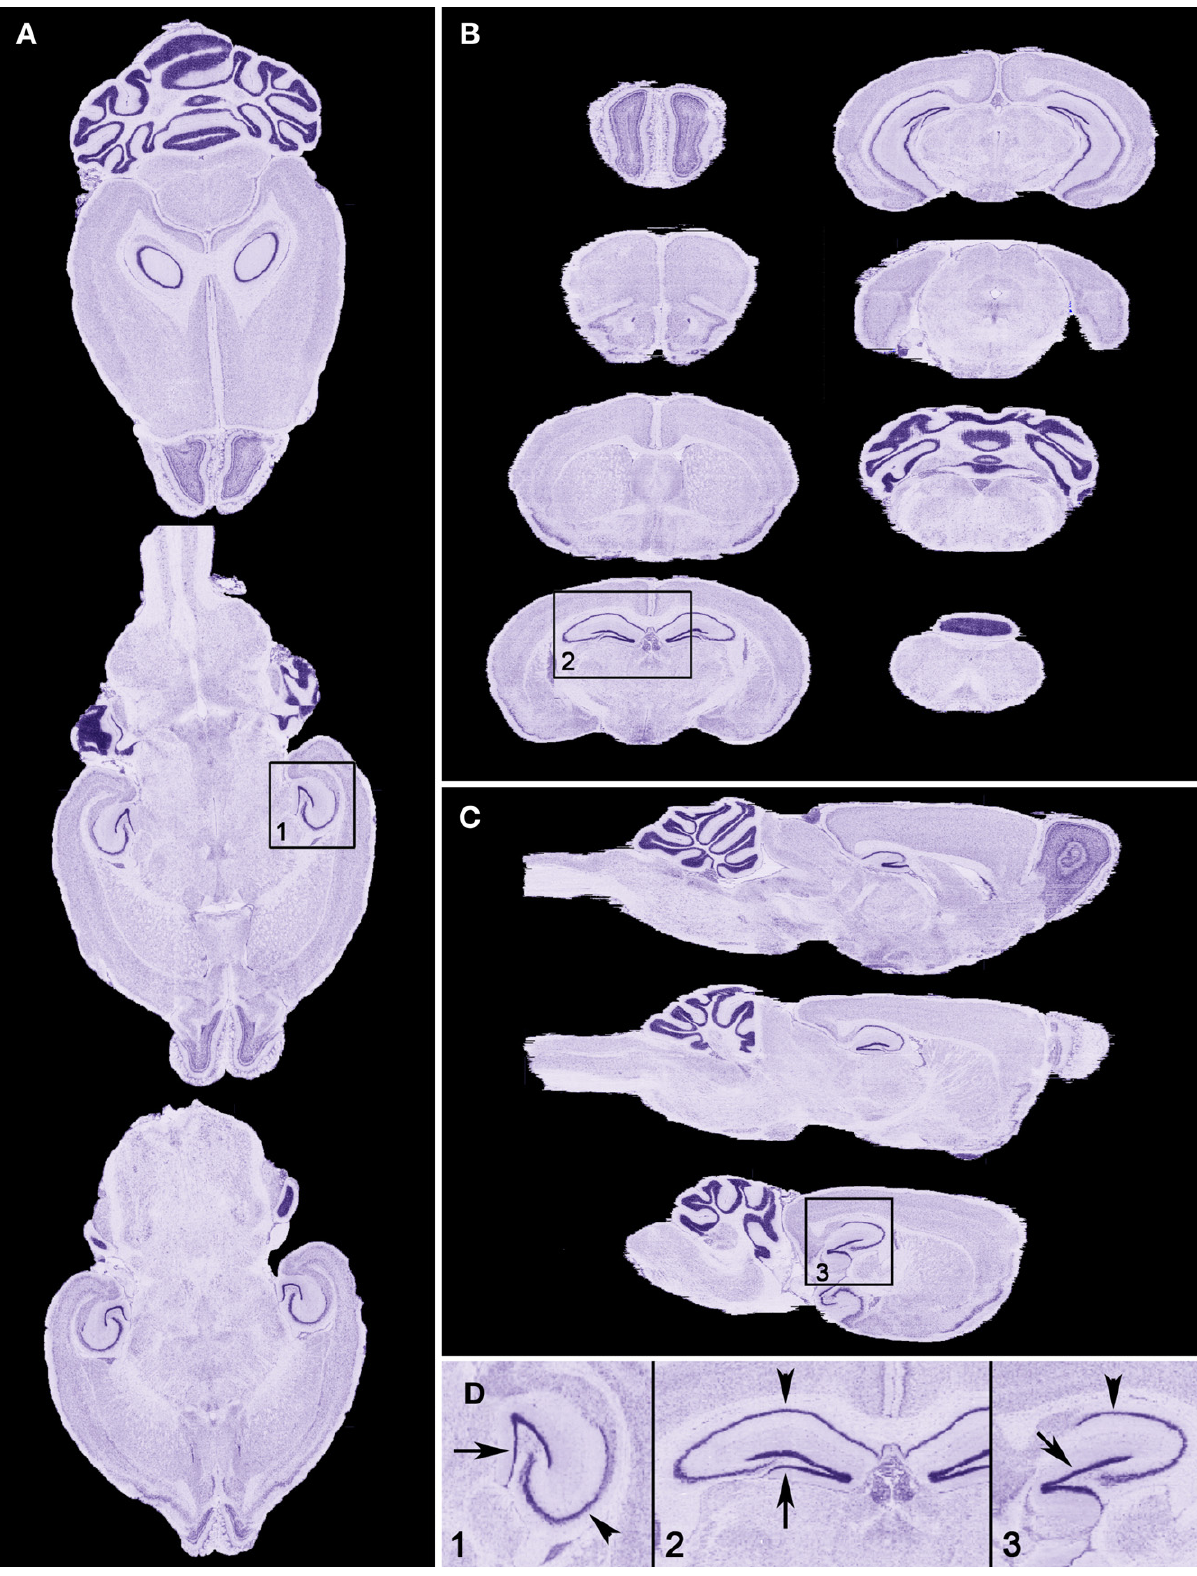
Figure 1 | Sectional views through the NMBA. The initial cutting plane during generation of the sectional material was horizontal (A) . The accuracy of the reconstruction can be appreciated from orthogonal resamples of the 3D volume along the coronal (B) and sagittal (C) planes and in the higher magnifi cation views in (D) taken from (A–C) . The smoothness of features such as the cell rich granular layer of the dentate gyrus (arrow in D ) and of the pyramidal layer of the hippocampus (arrowhead in D ) in all planes of view is indicative of effective registration. Note that application of gray value normalization has resulted in uniform staining intensity in all